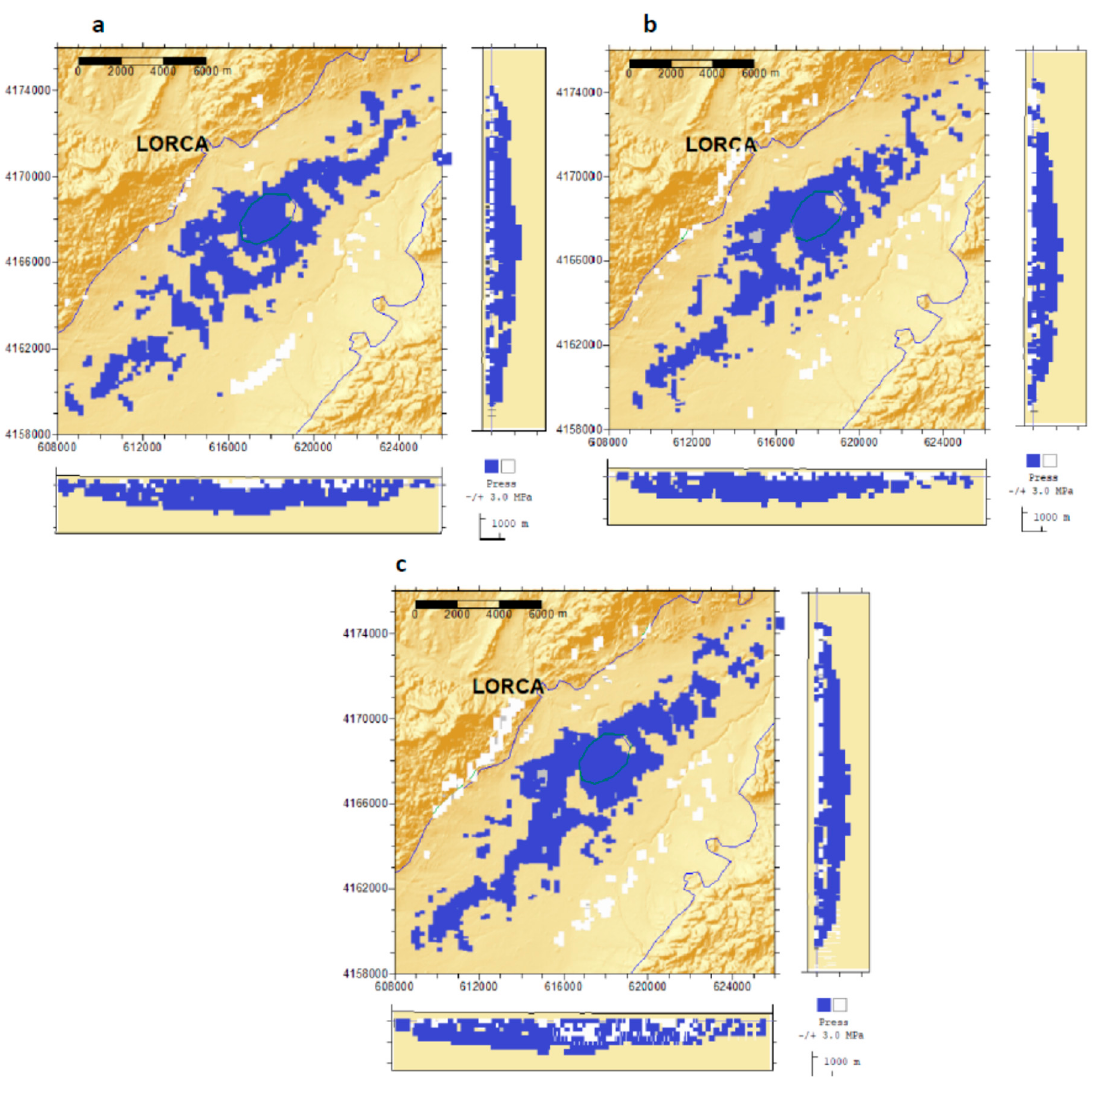
Figure 25. Representation of the inversion results obtained for the 1D considered data sets. (a) Obtained source for Case A ; (b) for Case B , and (c) for Case C . Blue color indicates negative pressure value cells, produced by water extraction. White color indicates positive pressure change cells. These positive pressure sources adjust the errors and the effects of other deformation sources, different from water extraction (e.g., of tectonic origin)